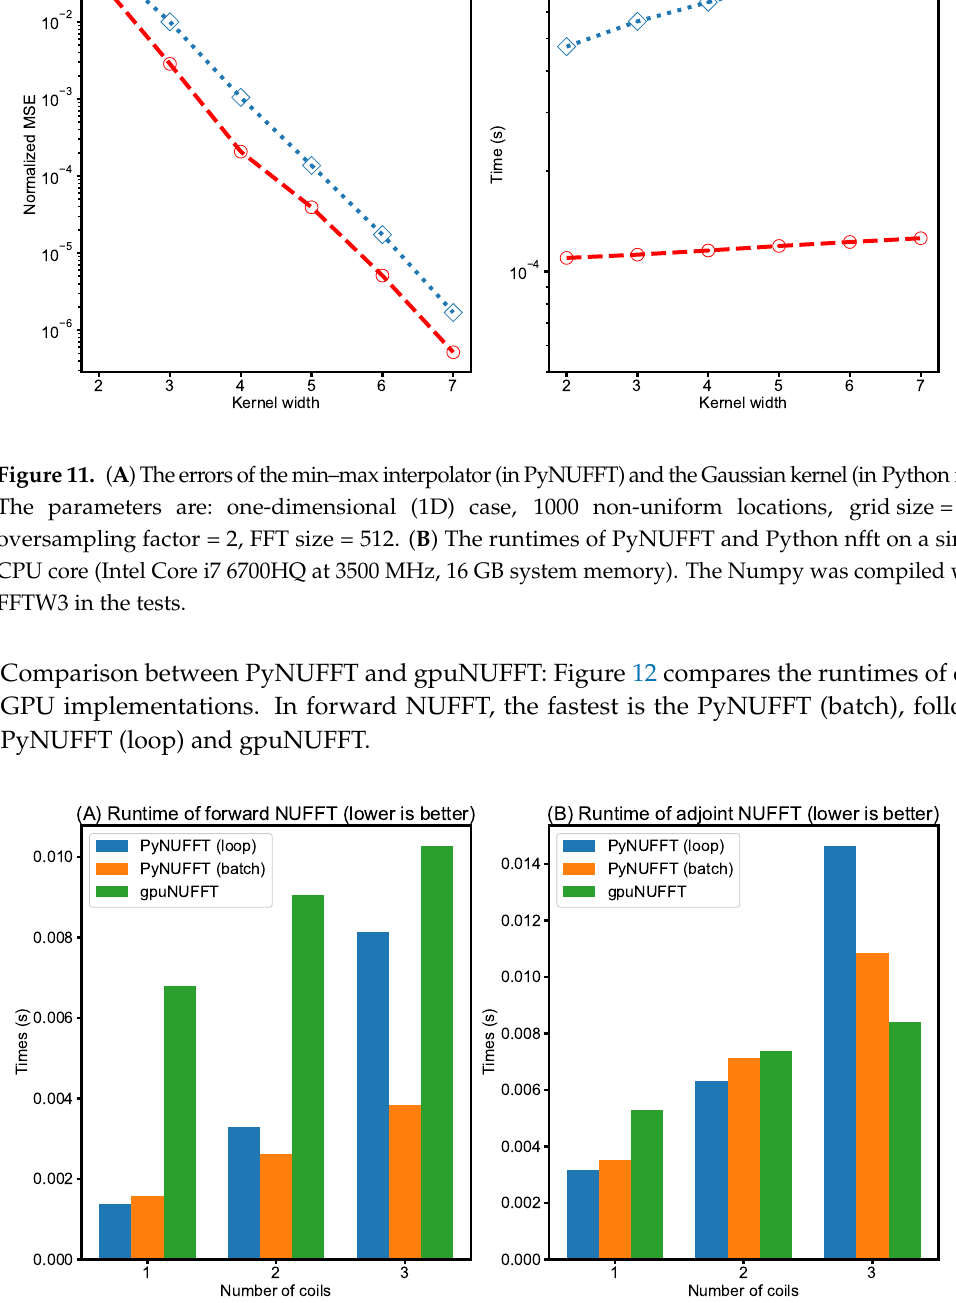
Figure 12. ( A ) Runtimes of forward transform in PyNUFFT (loop), PyNUFFT (batch mode) and gpuNUFFT ( B ) Runtimes of adjoint transform in PyNUFFT (loop), PyNUFFT (batch mode) and gpuNUFFT. The batch-mode PyNUFFT requires a large device memory, which is proportional to the number of coils. The benchmark used a radial k -space with 64 spokes in the test file in Knoll et al. [26]. NVIDIA GeForce 965 m with 945 MHz and 2 GB device memory is used as the GPU. The parameters of the test are: image size = 256 × 256, oversampling ratio = 2, kernel size =